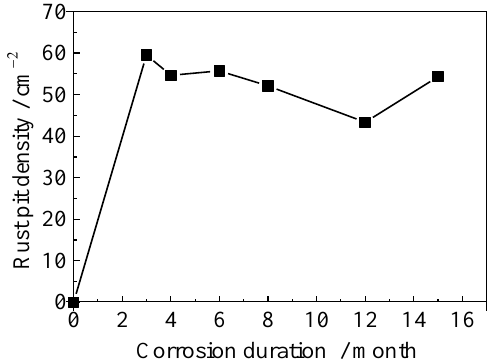
Figure 6. Rust pit density versus corrosion duration.